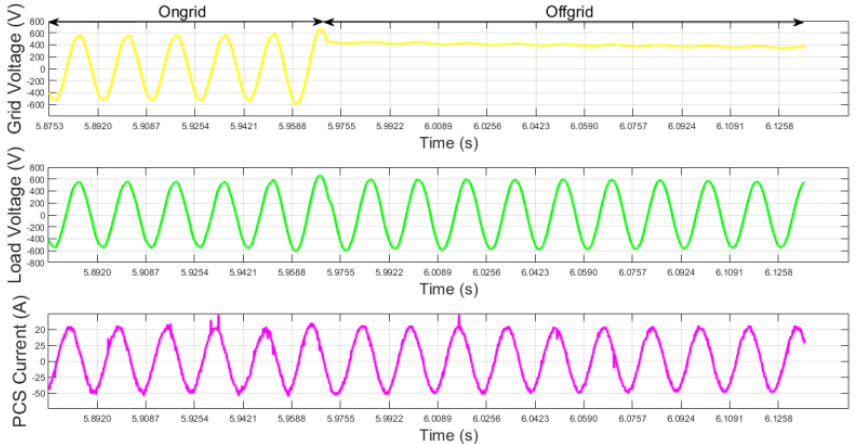
Figure 8. Stage 3: Backup on inductive loads — signal captured by the oscilloscope at the time the backup was simulated.